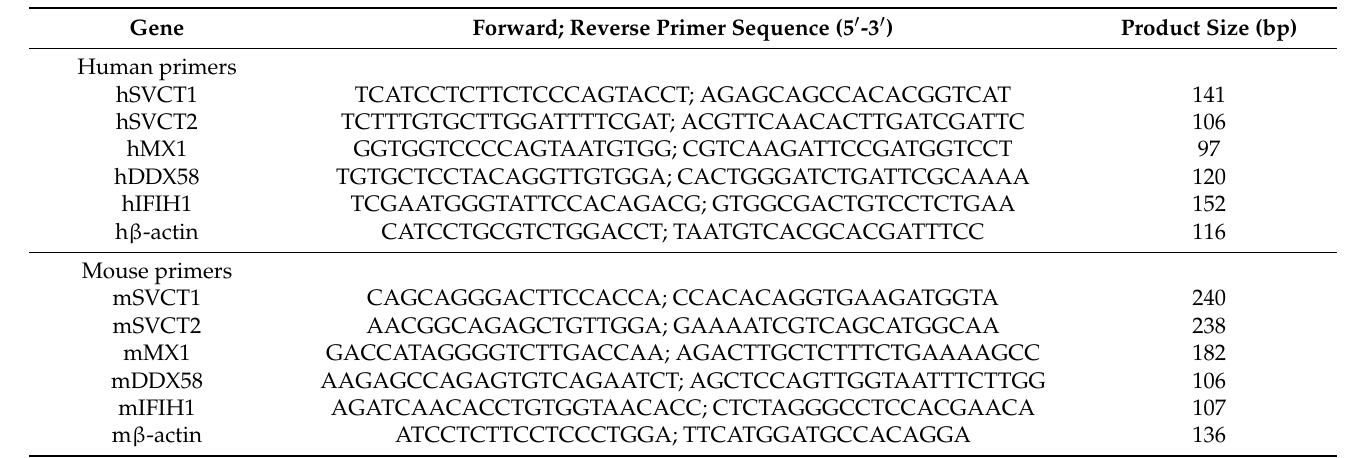
Table 1. Combination of primers used to perform